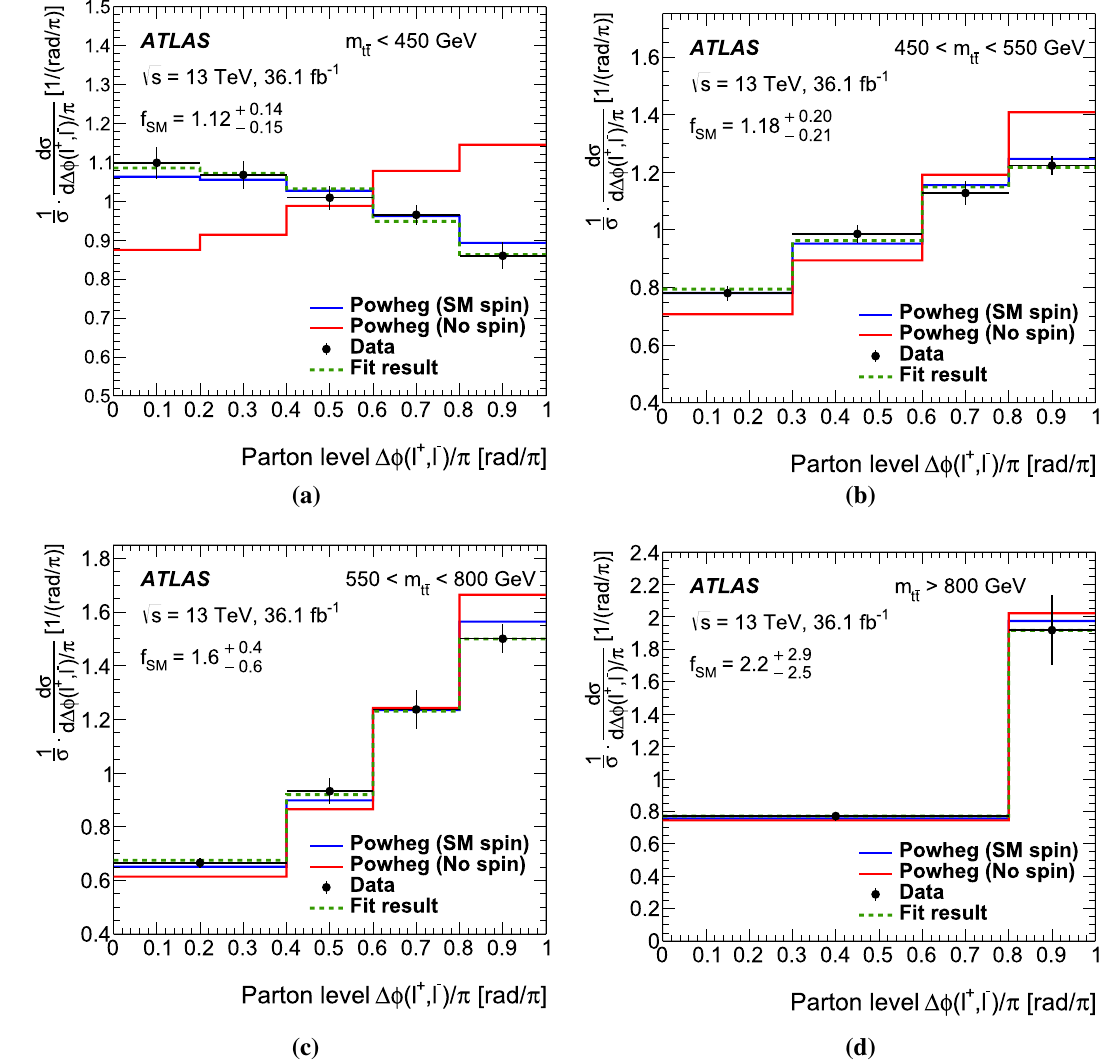
Fig. 12 Results of the fit of hypothesis templates to the unfolded data showing the (cid:3)φ distributions in m t ¯ t regions for the reconstructed selection: a m Table 6 Summary of extracted f SM values for each explored region with total uncertainties as well as the significance of the result with respect to the SM hypothesis. The significance with respect to the SM hypothesis is calculated using the statistical and systematic uncertain- ties on the data under a Gaussian assumption, together with the theory uncertainties on the hypothesis templates. The latter include the effect Region f SM ± (stat.,syst.,theory) Significance (excl.